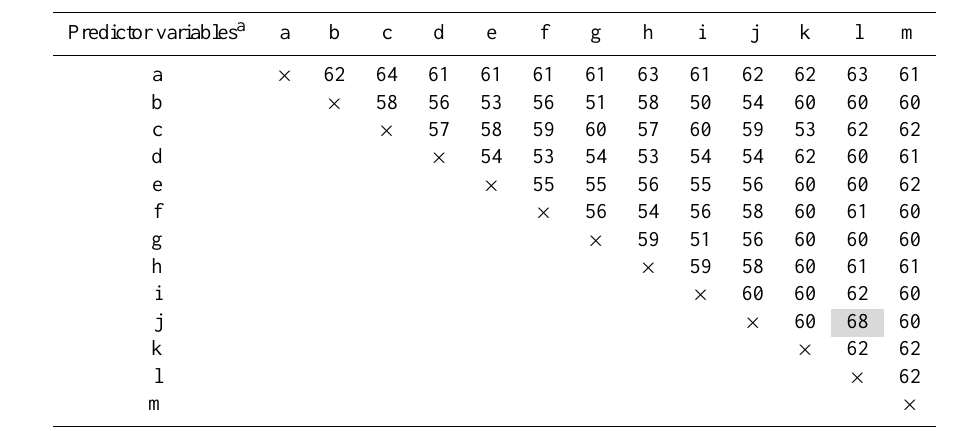
Table 3. Accuracy explained (%) for pruned classification tree models based on pairs of